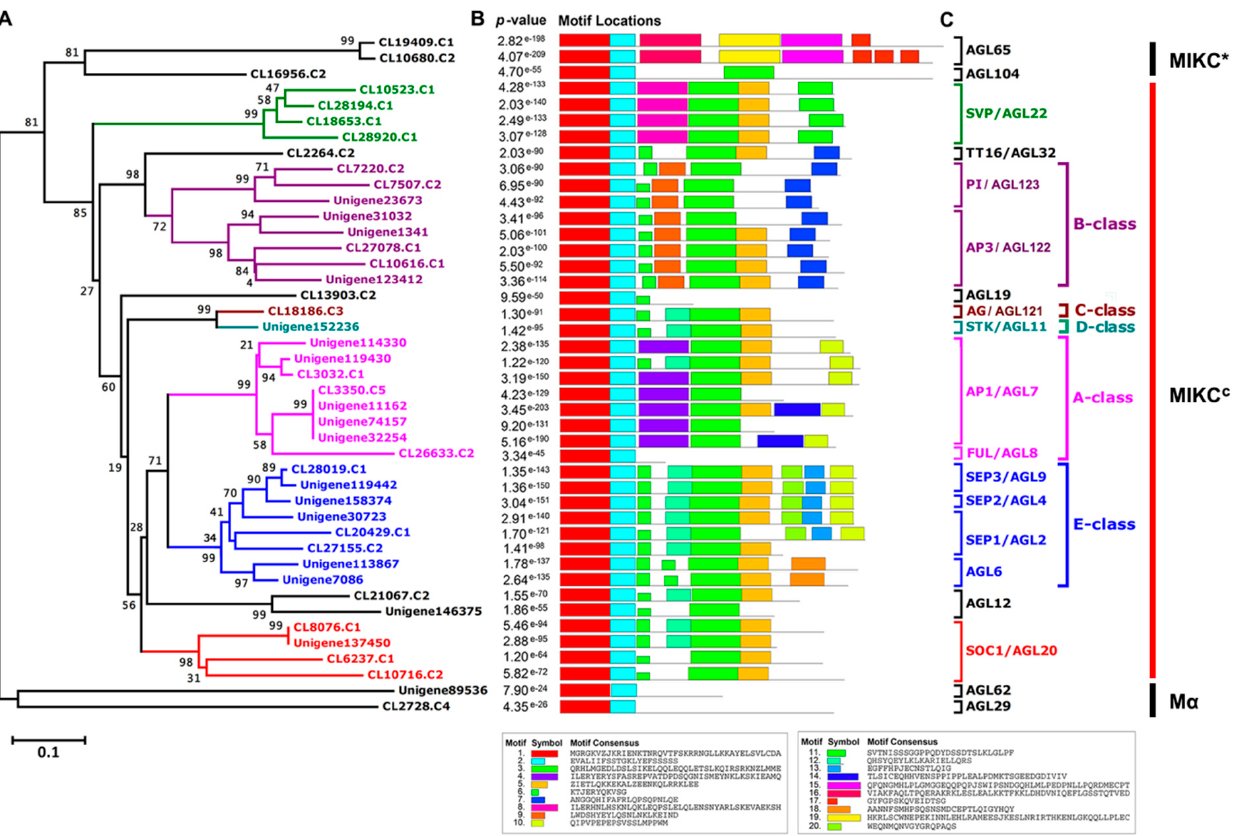
Figure 1. Classification and conserved motifs of MADS-box putative proteins in Adonis amurensis. ( A ) The phylogenetic tree of the identified 43 AaMADS putative proteins and their conserved motifs. ( B ) Motifs 1 to 20 are indicated by different colored boxes. The combined probability values are shown on the left side. ( C ) Classification and naming of 43 AaMADS putative proteins based on the similarity to Arabidopsis MADS-box homologous proteins. SVP: Short vegetative phase; AG: Agamous; AGL: Agamous-like; TT16: TRANSPARENT TESTA 16; PI: PISTILLATA; AP: APETALA; STK: SEEDSTICK; FUL: FRUITFULL; SEP: SEPALLATA; SOC1: Suppressor of overexpression of CONSTANS1; MIKC: MADS (M), intervening (I), keratin-like (K), and C-terminal (C) domain.